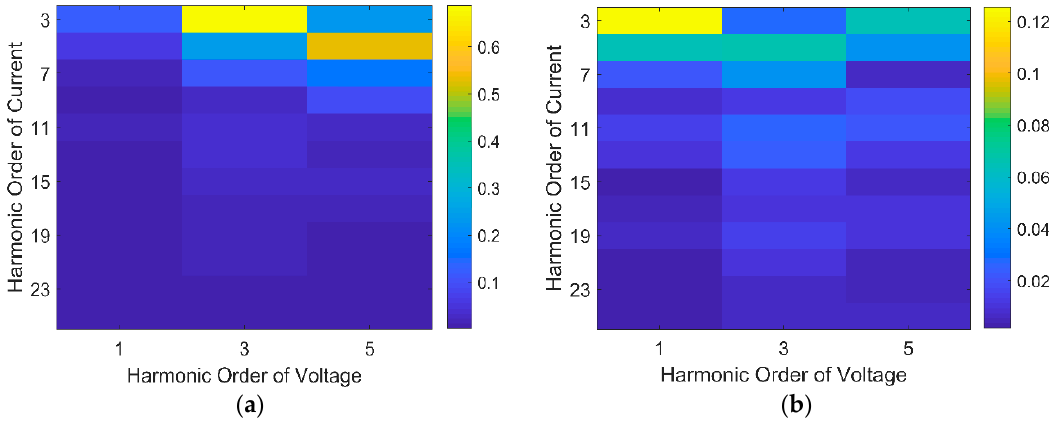
+ − ( a ) and Y ( b ), with unit Ohms. Figure 4. Magnitude of estimated admittance model Y + ( a ) and Y − ( b ), with unit